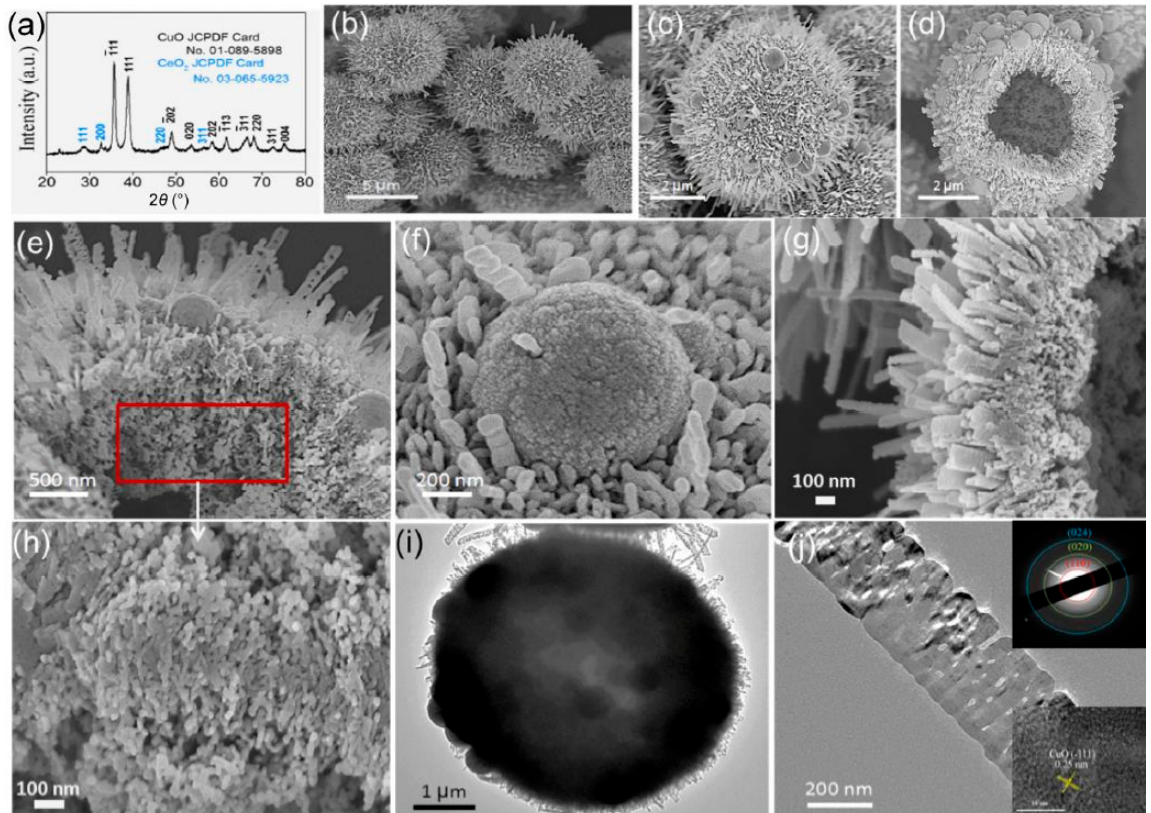
Figure 9. ( a ) Powder X-ray diffraction pattern, ( b – h ) FESEM images, ( i , j ) TEM images of CeO 2 -CuO hollow microspheres. The inset of panel ( j ) ( top right ) shows the corresponding SAED pattern, with the HRTEM image of CuO nanosheets shown at the bottom right [83]. Reprinted with permission from Springer Nature Customer Service Centre GmbH: Springer. Ji, Y.; Jin, Z.; Li, J.; Zhang, Y.; Liu, H.; Shi, L.; Zhong, Z.; Su, F. Rambutan-like hierarchically heterostructured CeO 2 -CuO hollow microspheres: Facile hydrothermal synthesis and applications. Nano Res. 2017 , 10 , 381–396.